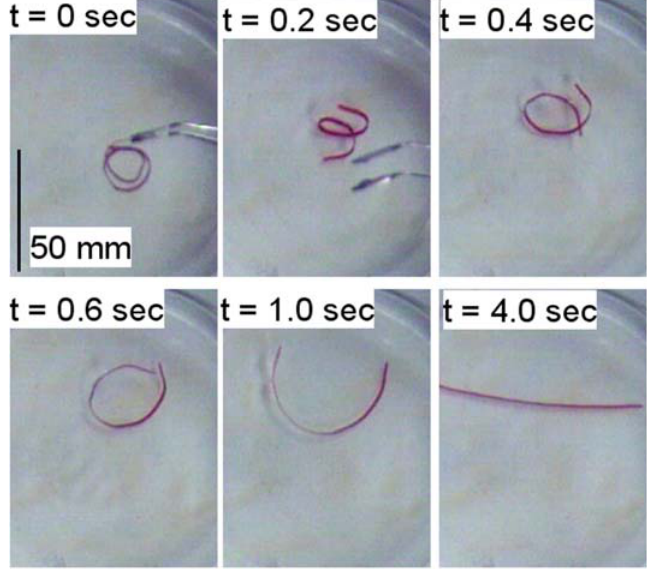
Figure 1. Shape recovery of coiled poly(lactic acid)/poly(vinyl acetate) (30:70) blend upon exposure to a water bath (65 °C). Reprinted with permission from [185]. (© 2003, Society of Plastics